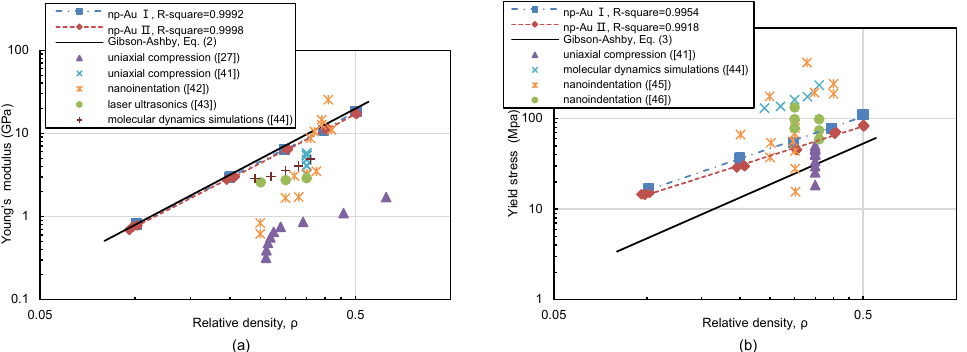
Figure 5. Variation of Young’s modulus ( a ) and yield stress ( b ) of nanoporous gold with relative density. Simulation results from this study for the two nanoporous gold samples are denoted as “np-Au I” and “np-Au II”. The solid line represents the Gibson and Ashby law with E lig = 79 GPa and σ lig = 500 MPa corresponding to bulk polycrystalline gold. Experiment results are also compared [27,41,49–53].